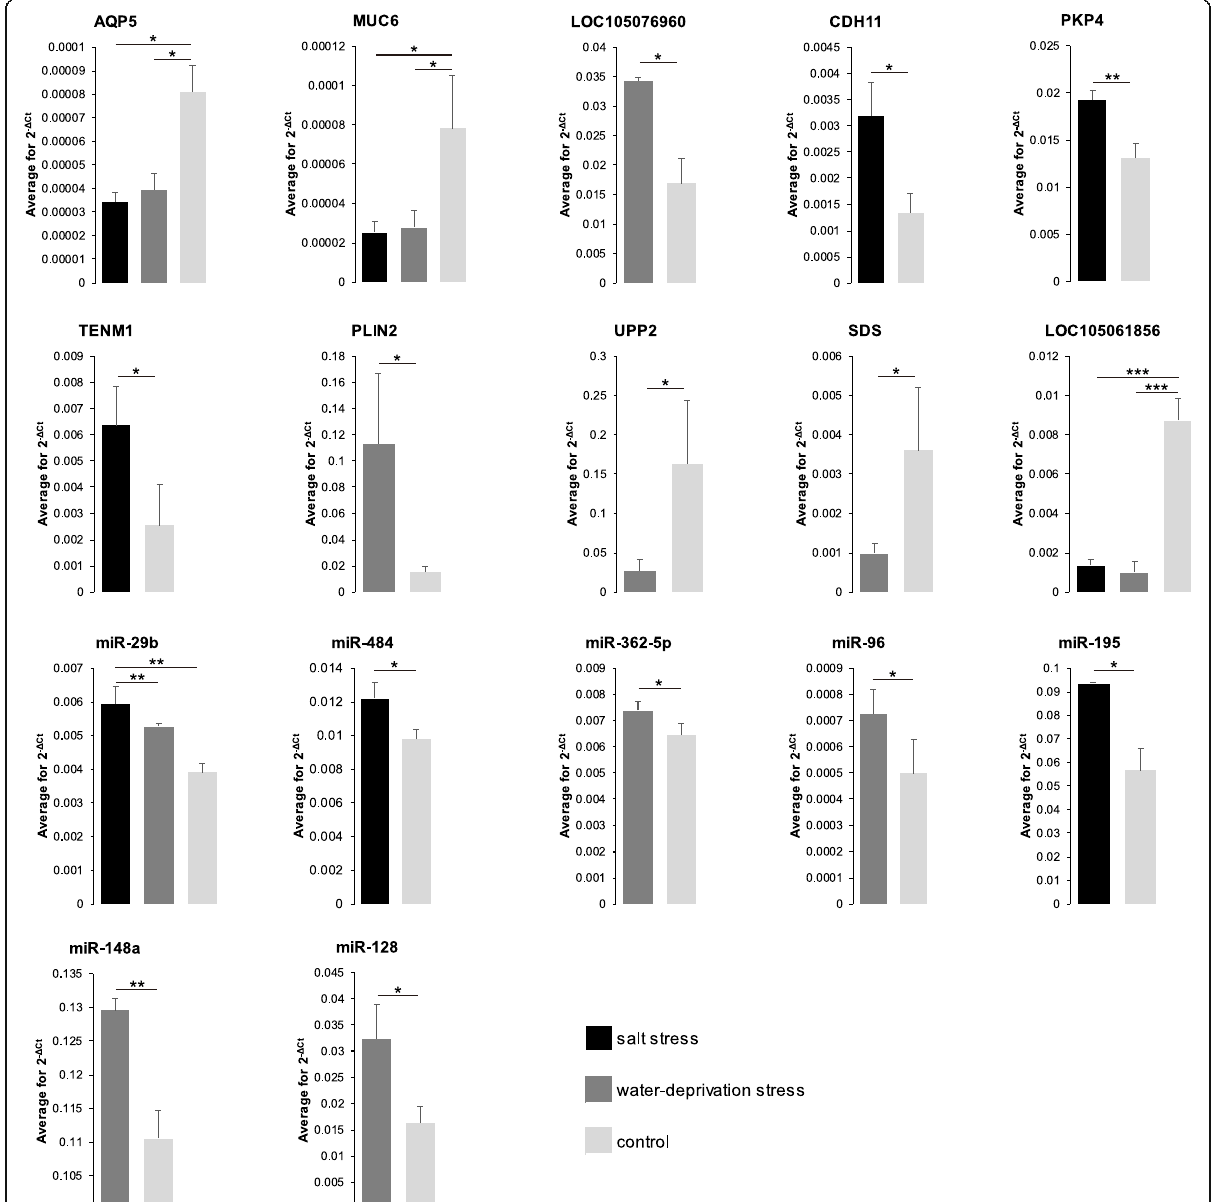
Fig. 3 qRT-PCR detection of candidate water-deprivation resistant genes. Data are presented as mean ± SD. Symbols: *, 0.01 < P < 0.05; **, 0.001 < P < 0.01; ***, P <